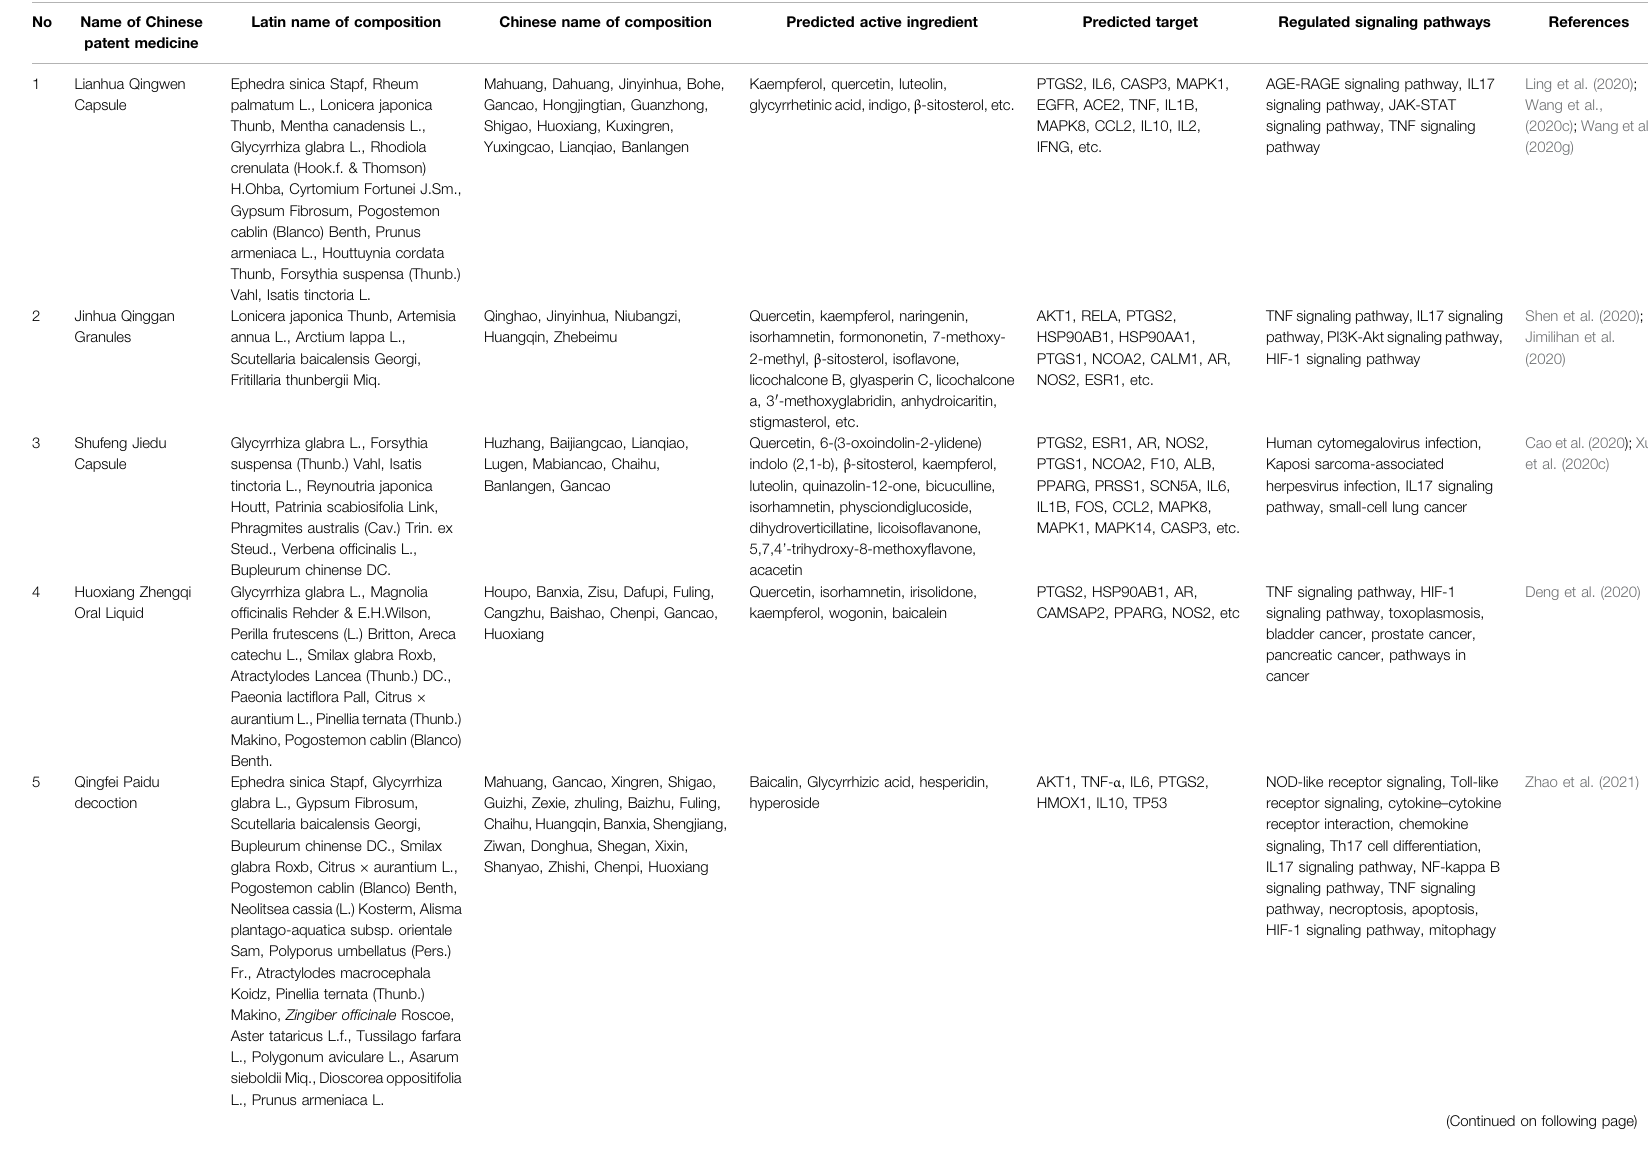
TABLE 3 | Summary of potential action mechanisms of CPMs for